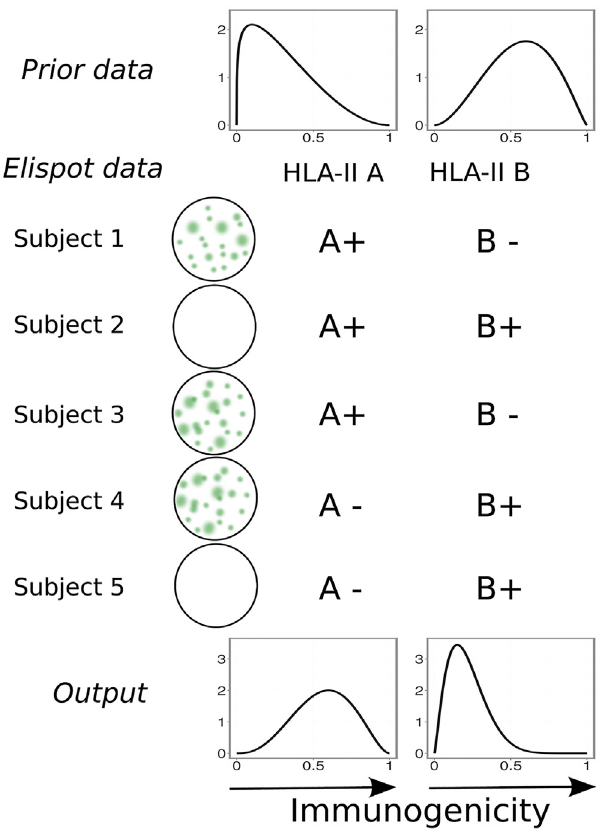
Fig 1. Outline of the algorithm. We aim to describe the immunogenicity of a peptide:HLA combination as a number between 0 and 1. For each subject, the outcome of the ELISpot assay is known, together with a list of their HLA alleles. The user can add prior knowledge in the form of a prior distribution. In the example, the prior knowledge describes the belief that HLA class II allele A is not immunogenetic in combination with the peptide, while HLA class-II allele B is. The output of the algorithm consists of posterior marginal distributions of the values E j . In the example, it is found that allele A is more immunogenic that allele B in combination with the